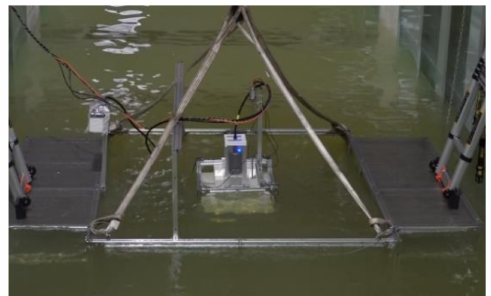
Figure 11. Model test of regular wave.